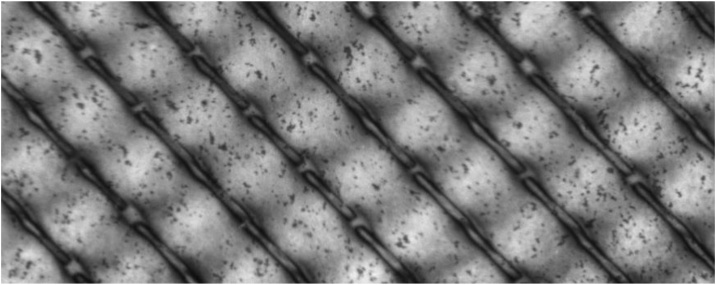
Membrane with stained deposit layer. The deposit layer pattern was generated by a 44 mil diamond spacer. Filtration conditions: 0.5 bar transmembrane pressure; 1.0 bar m−1 axial pressure drop; skim milk CF 3; 10 °C. The mean deposit layer content was 5.3 g m−2 (by RP-HPCL) with a maximum local concentration >10 g m−2.